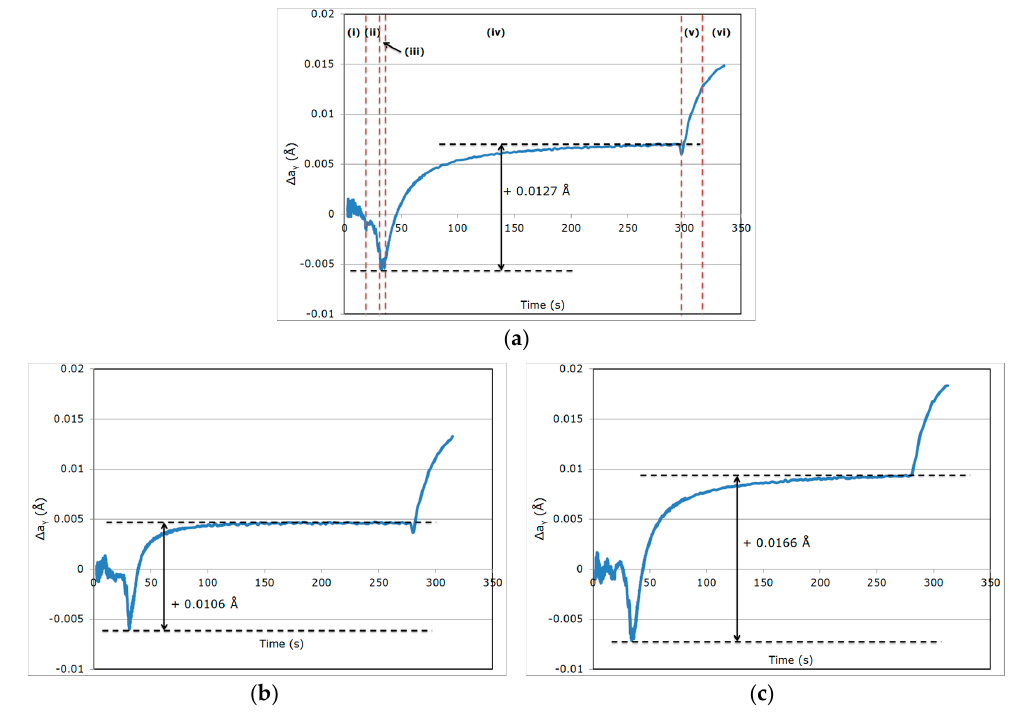
Figure 5. Evolution of Δ a γ as a function of time: ( a ) Q&P reference cycle, ( b ) QT = 230 °C/PT = 450 °C cycle, and ( c ) QT = 200 °C/PT = 400 °C cycle. The different steps discussed in the text are indicated in Figure 5a. In each figure, the increase in the lattice parameter during step (iv) is reported. This increase was attributed to a carbon enrichment in austenite due to both partitioning and bainitic transformations. The error made on the lattice parameter measurements was about ±0.0002 Å after Fullprof analysis.